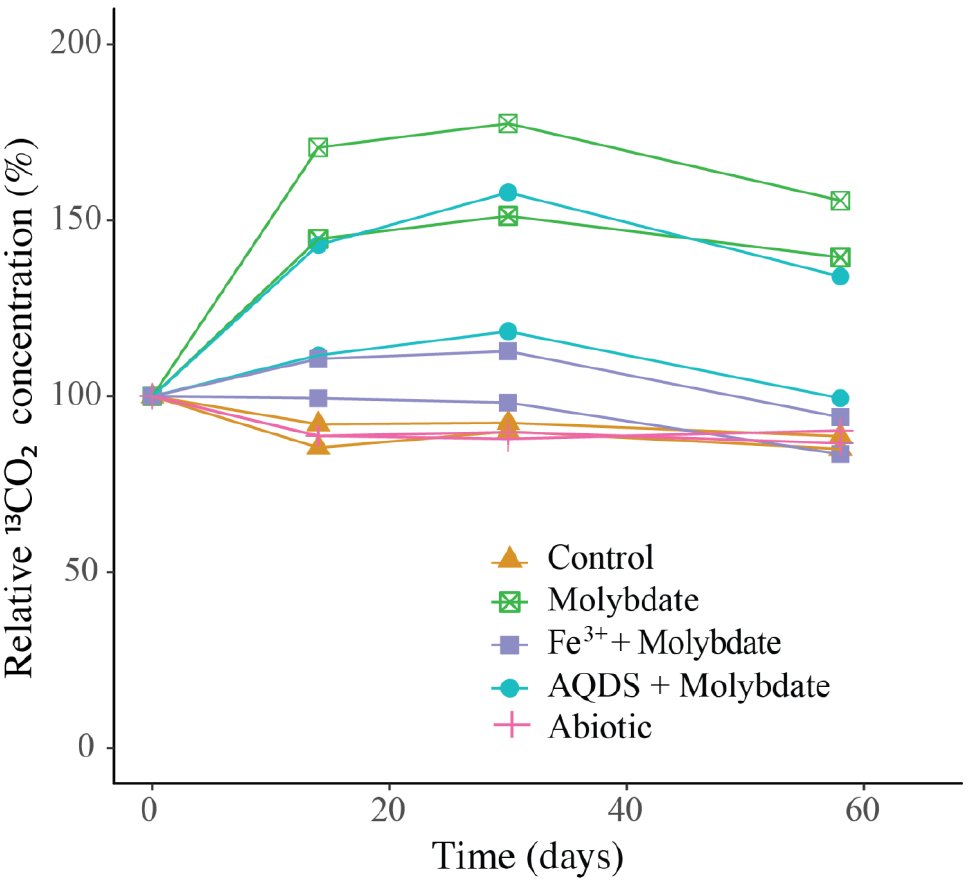
Figure 3. Change over time of 13 CO 2 in the incubation experiments, normalized to the concentration at t 0 ( t 0 = 100%). The duplicate incubation bottles of each experiment are both shown individually. Actual concentrations are shown in Figure S3.